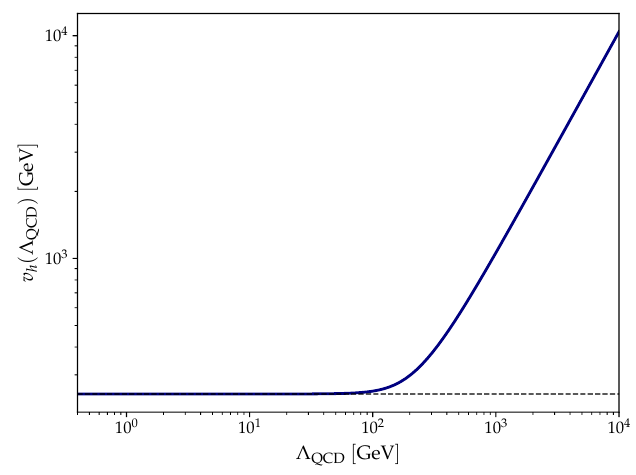
Figure 2 . The value of v h immediately after early confinement is triggered, as a function of the early confinement